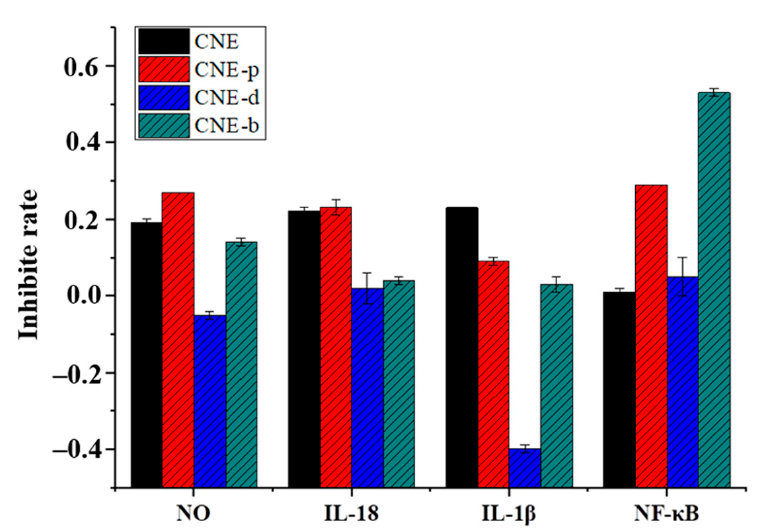
Figure 2. Influence of extracts obtained from C. nudiflora on changes in the inflammatory cytokines NO, IL-18, IL-1 β , and NF- κ B on RAW264.7 cells. Table 1. Influence of CNE-p, compounds 1 and 2 on changes of NLRP3 in LPS-injured RAW264.7 cells ( n =